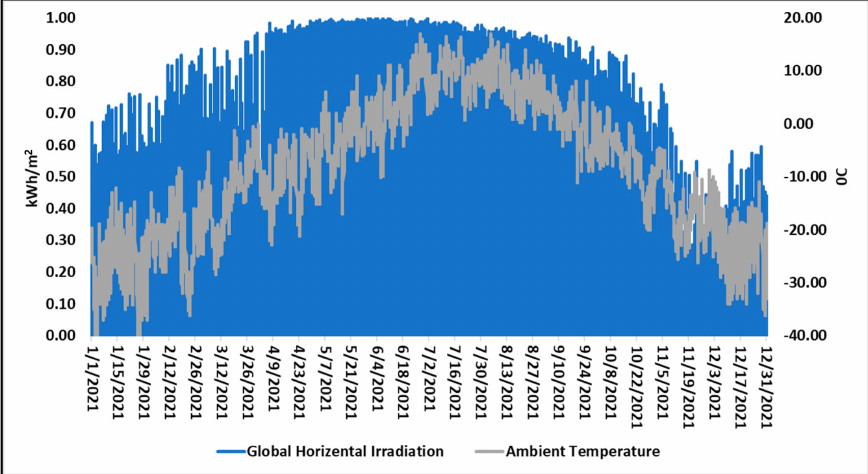
Figure 7. Hourly solar irradiation and ambient temperature in UB [44]. The emission factors used in the calculation are given in Table 5. Table 5. Emission factors used in this study [45]. Emission Factors